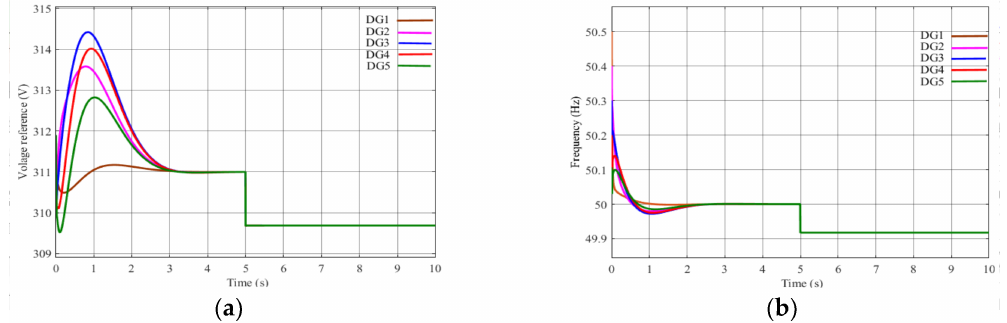
Figure 5. Simulation results of voltage-frequency recovery and synchronization. ( a ) Voltage; ( b )